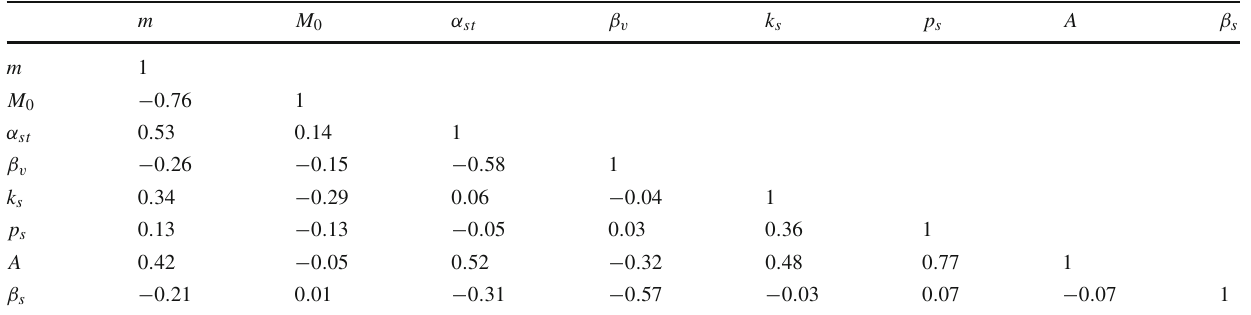
Table 4 Correlation matrix for the parameters of potential II